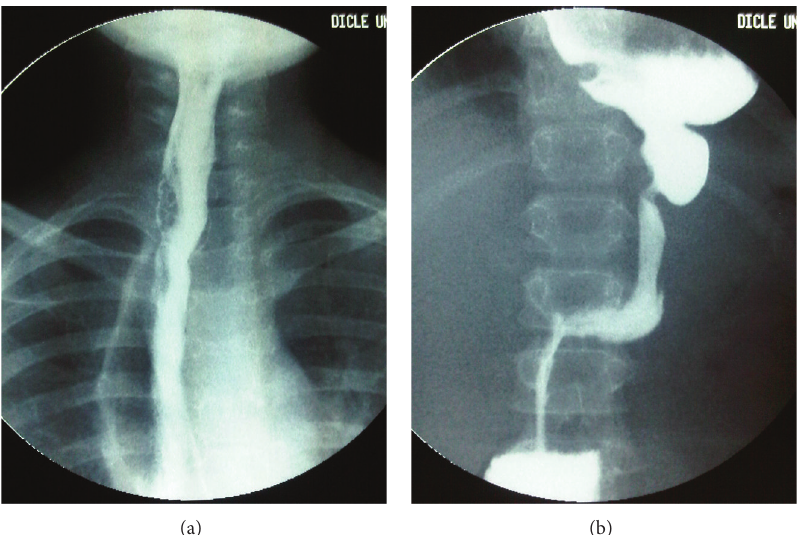
Figure 2: Barium swallow study after a gastric pull-up procedure. (a) Cervical esophagogastrostomy and stomach in the mediastinum. (b) Pylorus and duodenum in the